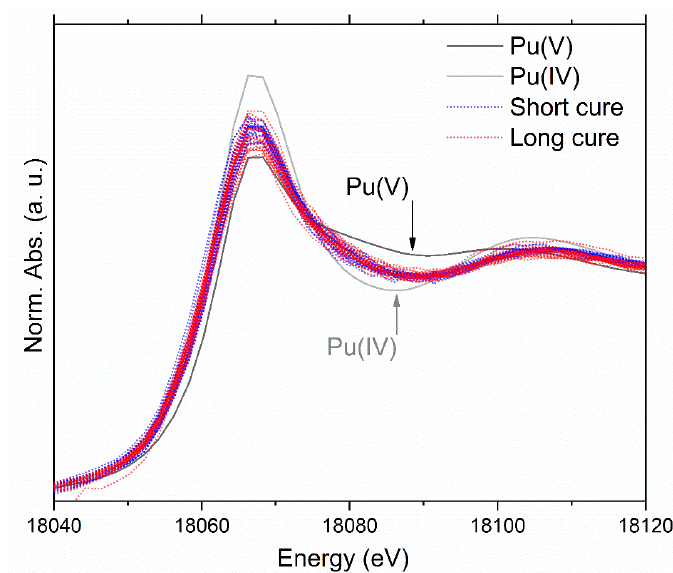
Figure 6. Pu L 3 edge XANES from all sampling points with comparative standards of Pu(IV) aq (grey) and Pu(V) aq (black) [17]. Spectra in blue dots are from samples 1 and 2, (short 13-day cure) and spectra in red dots are samples 3 and 4 (long 130-day cure). Geosciences 2018 , 8 , x FOR PEER REVIEW